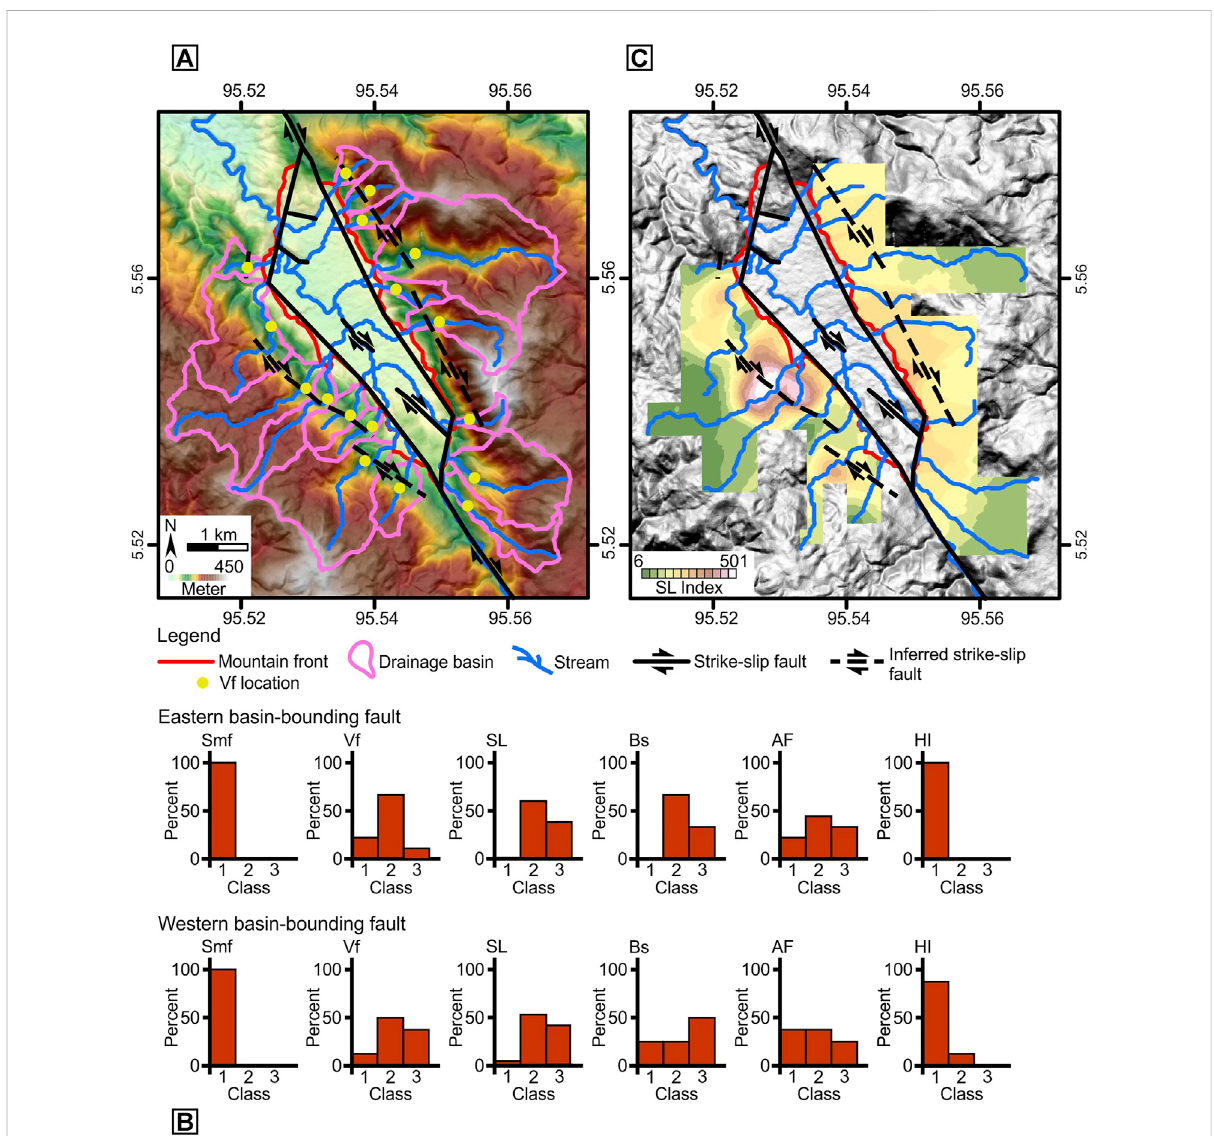
FIGURE 5 The Krueng Raya Basin: (A) the mountain fronts, faults, and drainage basins, (B) classi fi cation of geomorphic indices, and (C) stream length- gradient map.